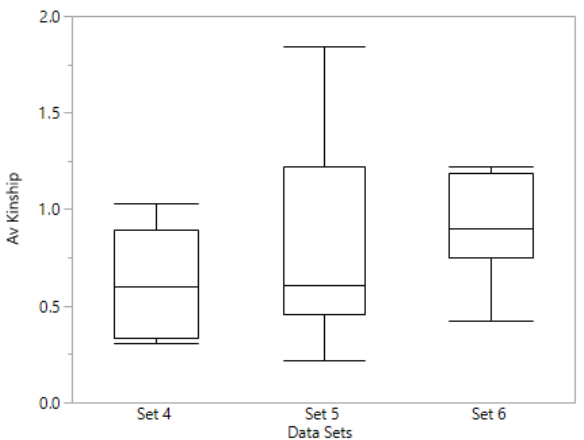
Figure 3. Boxplots for average kinship based on family means for each data set of preliminary wheat breeding lines grown at two locations in Kentucky, 2018.